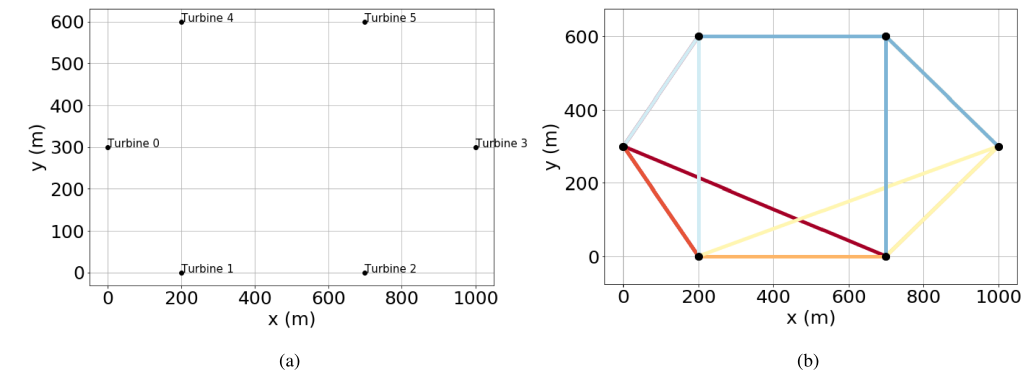
Figure 1. (a) Example six-turbine wind farm. (b) Example clustering based on the nearest three neighbors. The different colors represent the different clusters. For example, the darker blue lines indicate that Turbines 2, 3, and 4 are communicating with Turbine 5.